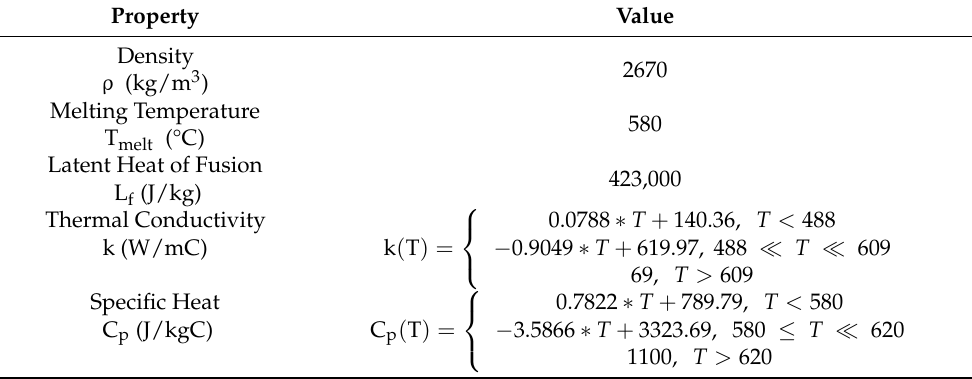
Table 1. Material Properties of AlSi10Mg